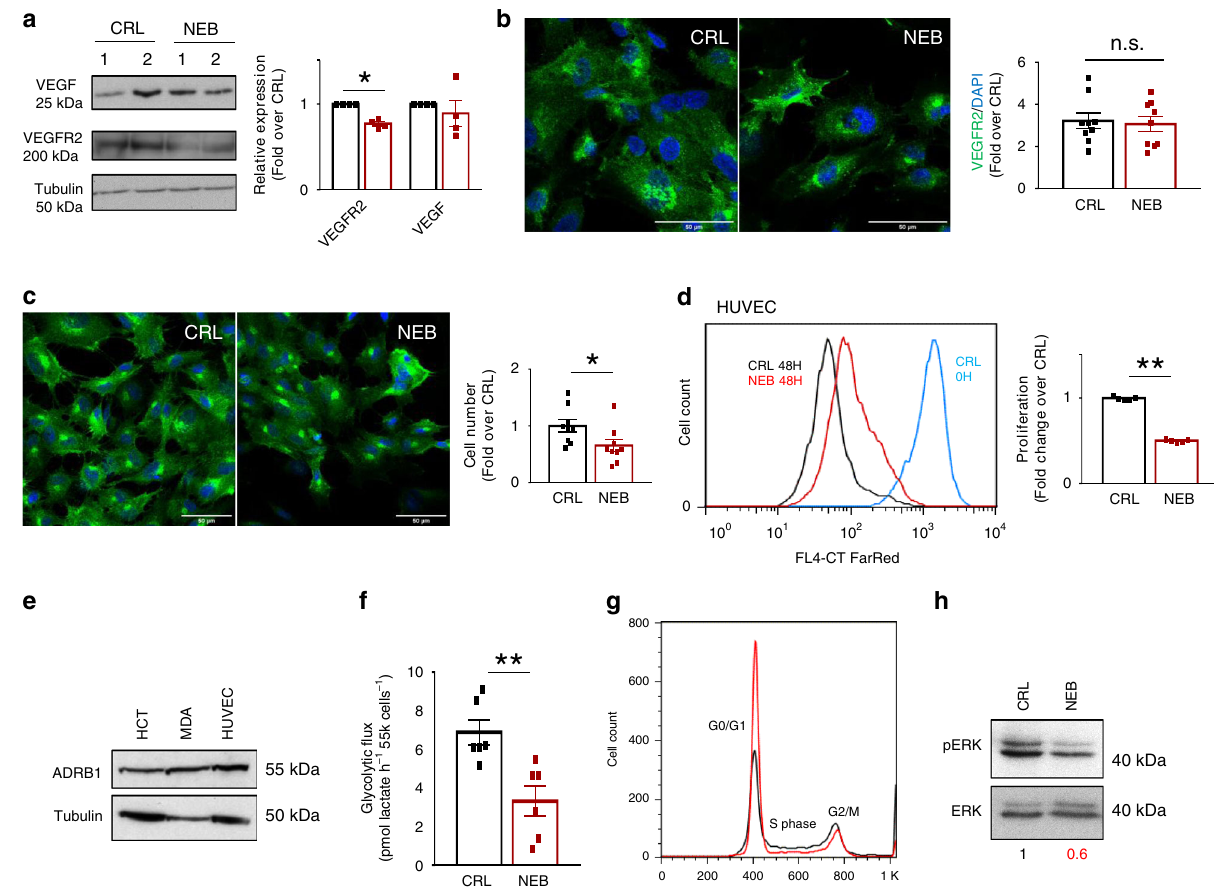
Fig. 6 Nebivolol inhibits endothelial cells metabolism and proliferation. a Representative western blots of two different samples and quanti fi cation of four different samples (histograms) of the expression of VEGF and VEGFR2 (* p = 0.01) in tumors of control (CRL) and nebivolol-treated (NEB) colon xenograft mice. Tubulin is shown as loading control. b – h HUVEC cells were treated (NEB, red dots and bars) or not (CRL, closed dots and bars) during 3 or 48 h with 10 µ M nebivolol. b Immuno fl uorescence microscopy images of VEGFR2 (VEGFR2, green) and DAPI (blue)-stained HUVEC treated as indicated. Scale bar, 50 µ m. Histograms represent the relative expression of VEGFR2-positive cells relative to cell nuclei from nine different slices. c Immuno fl uorescence microscopy images of VEGFR2 (VEGFR2, green) and DAPI (blue)-stained HUVEC treated as indicated. Scale bar, 50 µ m. Histograms represent the number of cells from nine different slices. * p = 0.03. d The fi gure shows the proliferation after 48 h of CellTrace Red Far incorporation. The blue curve shows time 0. The plot shows the quanti fi cation of cellular proliferation of four different samples. ** p = 3.1E − 10. See Supplementary Fig. 7c for gating strategy. e Representative western blot of the expression of β 1-adrenergic receptor (ADRB1) in cancer and in human umbilical vein endothelial cells (HUVEC). Tubulin is shown as loading control. Western blots were repeated three times with similar results. f Glycolytic fl ux measured by the initial rates of lactate production of six different biological samples are shown. ** p = 0.005. g Plot shows the percentage of cells in G0/G1, S and G2/M phases of the cell cycle from three different samples. See Supplementary Fig. 7d for gating strategy. h Representative western blot of the expression of ERK and its phosphorylated form (pERK). Western blots were repeated two times with similar results. Bars indicate the mean of the indicated samples ± SEM. * p < 0.05 and ** p < 0.01 when compared to CRL by two-sided Student ’ s t test. See also Supplementary Fig. 6. Source data are provided as a Source Data fi